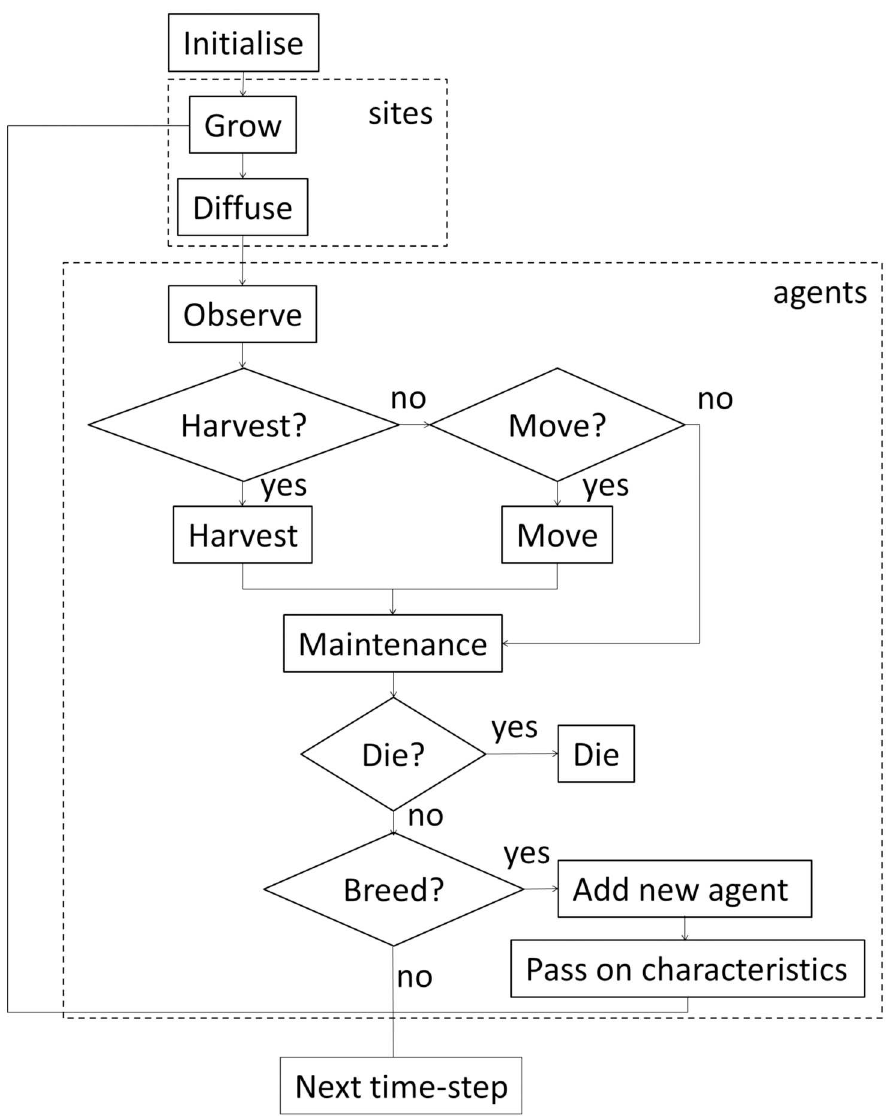
Fig 4. Model flow chart. The dashedboxes indicate loops over all sites or all agents. For detailed explanation we refer to